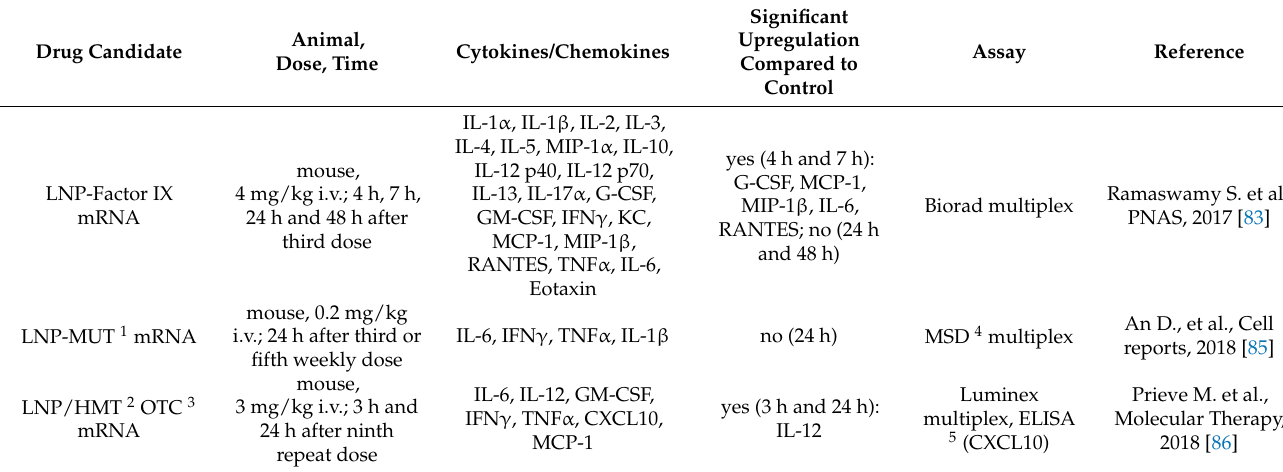
Table 2. Overview of preclinical studies that have examined cytokine/chemokine secretion in current RNA Protein Replacement